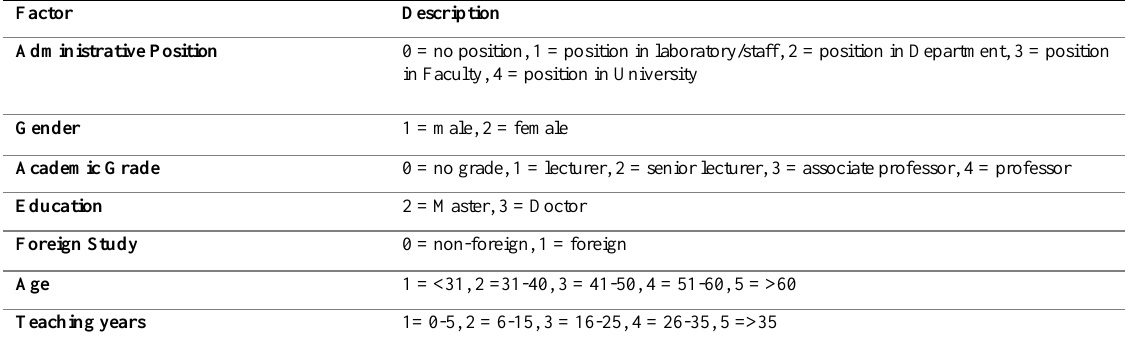
Table 1 : Description of Factors tested